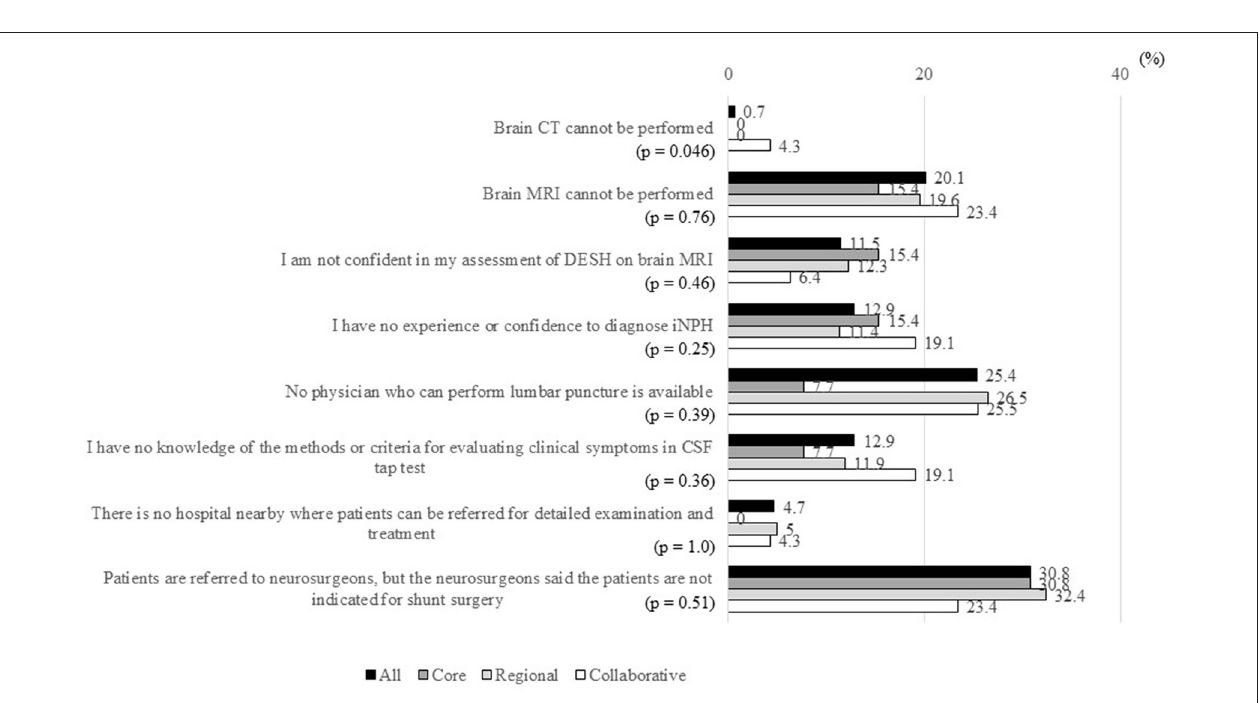
Frontiers in Neurology | www.frontiersin.org 7 May 2022 | Volume 13 | Article